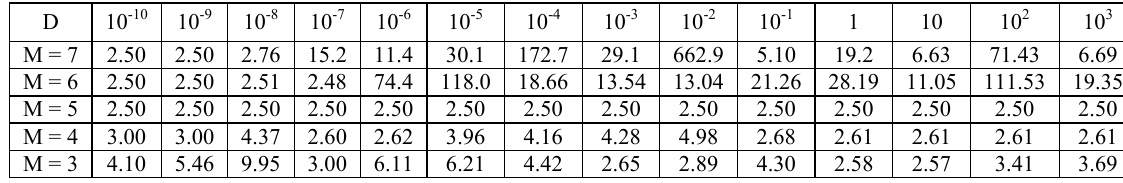
Table 2. The results of the WS estimation at 50-180 m heights based on measured WS at 10-40 m heights